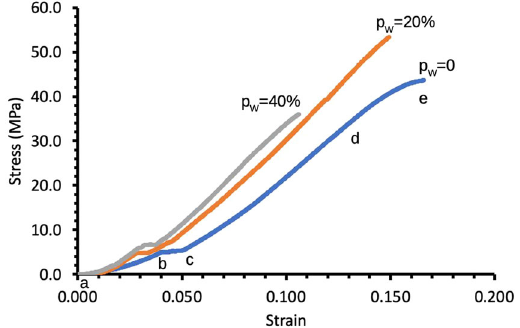
Fig. 3 Optical micrographs of PLGA/PVA scaffold treated to the respective sonication power levels, 0, 20 ( p W ), and 40% ( p W ), at 5, 15, and 30 min soaking duration. Here, each panel (a to i) shows the surface of a PLGA specimen, corresponding to a speci fi c treatment level. For instance, the image in panel a was derived from a specimen treated at p W = 0% and t = 5 min. Scale bar indicates 100 μ m